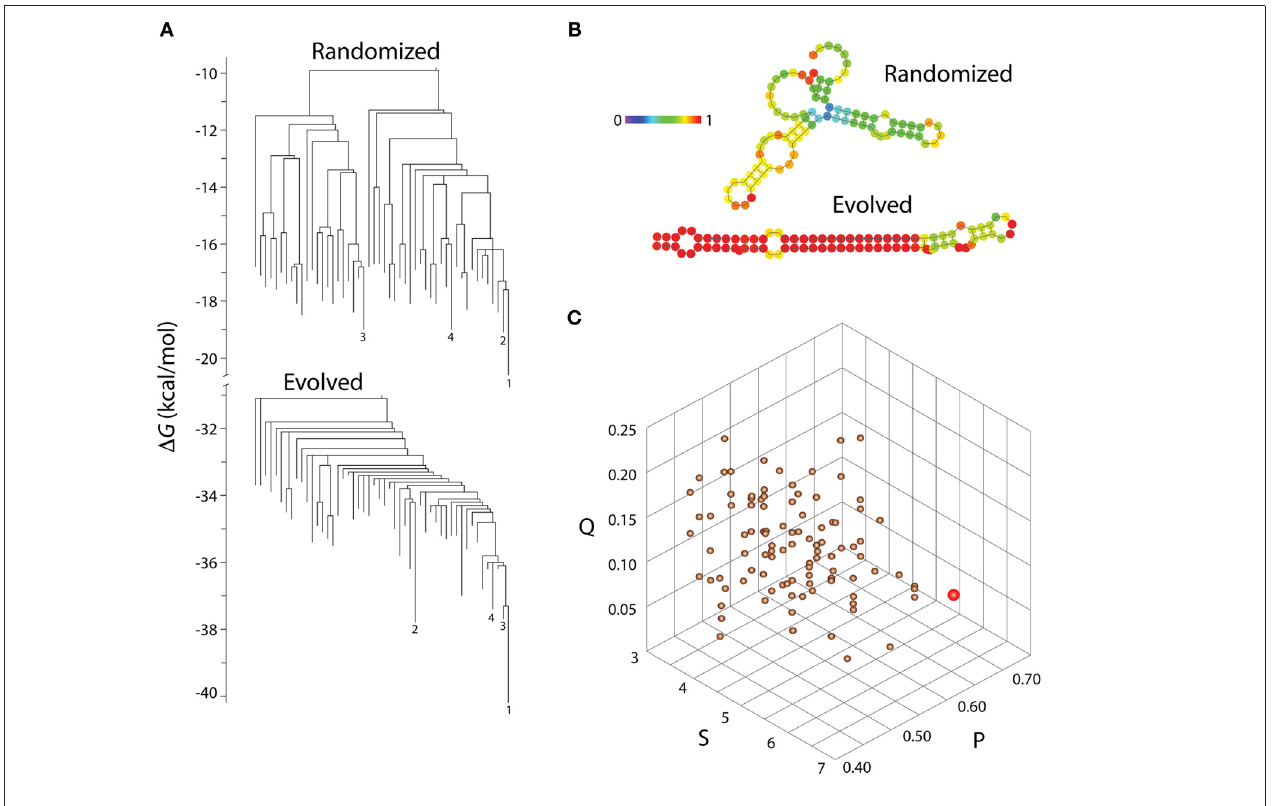
FIGURE 3 | Evolution of molecular shapes. (A) Barrier trees describing the low energy portion of the free-energy landscape of a naturally evolved molecule, let-7-a-1, a micro RNA stem loop from zebrafish ( Danio rerio ) that is 89 nt long (Chen et al., 2005), and its randomized derivative. Barrier trees describe the likelihood of conversion (at constant temperature) of one shape configuration into another, with leaves representing shapes (macrostates corresponding to local energy minima), branch lengths (vertical dimension of the tree) representing free energy ( (cid:2) G), and internal nodes connecting branches representing energy barriers (basins) that limit transformation between shapes. The randomized structure is one out of 100 obtained using OMROKGEN (Knudsen and Caetano-Anollés, 2008) and shows a more degenerate energetic landscape. Barrier trees were obtained with the software Barriers (Flamm et al., 2002) and computed with the Vienna RNA webservers (http://rna.tbi.univie.ac.at/). (B) Minimum free energy secondary structures of the evolved microRNA and its randomized derivative.